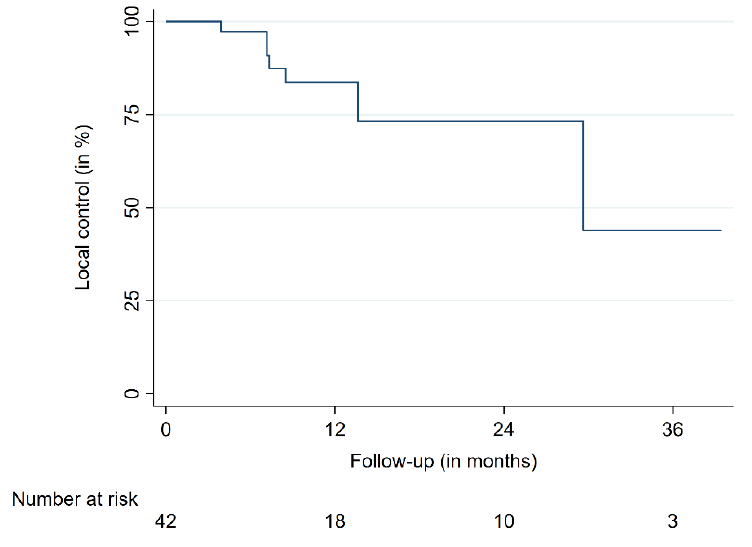
Figure 1. Local control.